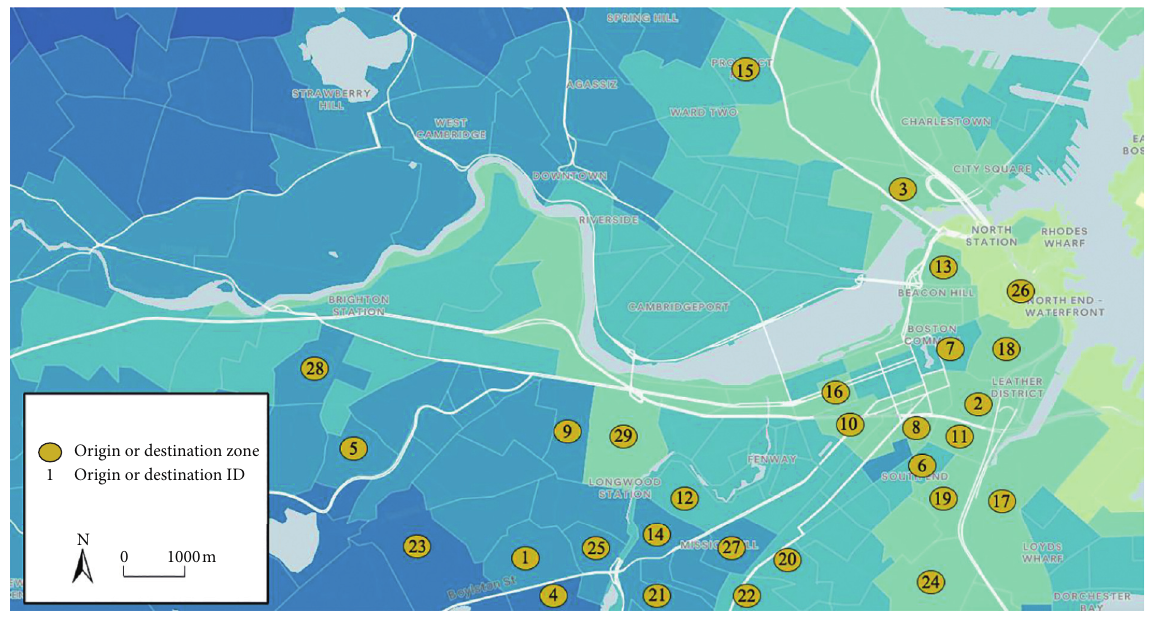
Figure 1: The origin and destination nodes. Table 1: O-D pair information in each range of TTR.